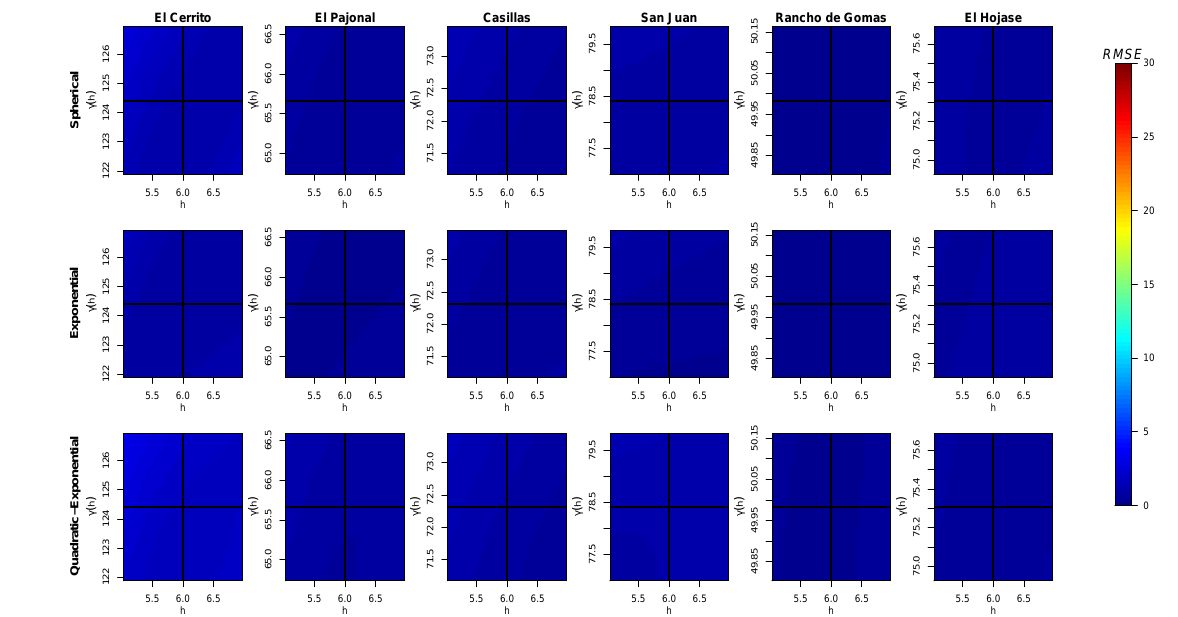
Figure A4. Obtained values of RMSE (color bar) for different pair of data ( r , γ ( r )) when fitting a curve for the variogram of each station with the three models and considering the nugget effect. The intersection of the black solid lines tags the real position ( r , γ ( r ))